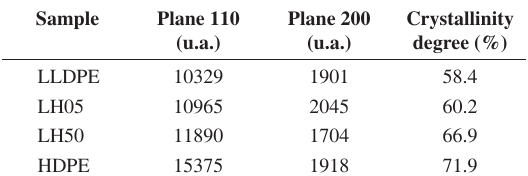
Table 3. Peak intensity and crystallinity degree values obtained by